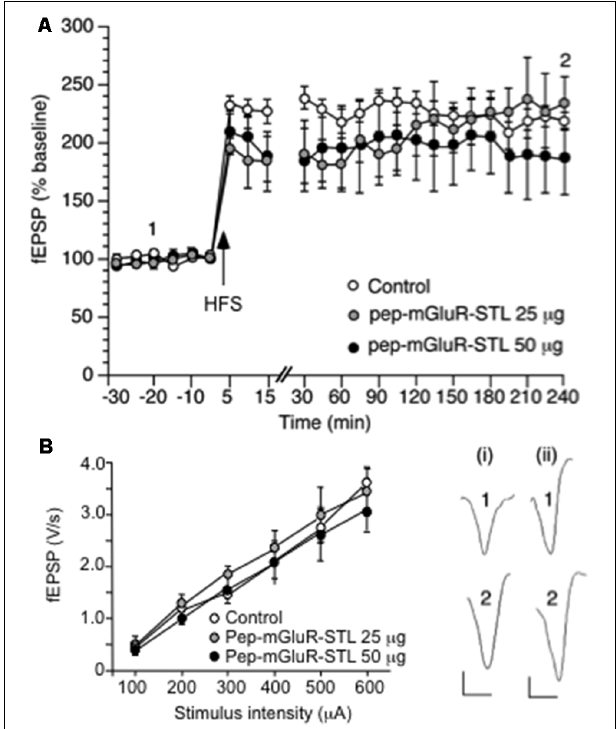
FIGURE 2 | Long-term potentiation (LTP) and the stimulus-response relationship are not altered by pep-mGluR-STL. (A) High frequency stimulation (HFS) induces robust LTP that lasts for at least 4 h in the CA1 region of hippocampal slices from animals that were treated with control peptide ( n = 8). Treatment of animals with pep-mGluR-STL (25 µ g, n = 5, or 50 µ g, n = 5), has no effect on the expression of LTP. Line-break indicates change in time-scale. Analogs represent responses elicited in the presence of: (i) control peptide; and (ii) pep-mGluR-STL (25 µ g) at the time-points noted. Vertical bar: 1 mV, Horizontal bar: 10 ms. (B) Comparison of the stimulus–response (input/output) relationship in hippocampi from animals that had been treated with control peptide, 25 µ g or 50 µ g of pep-mGluR-STL (all n = 7) revealed no differences in field excitatory postsynaptic potential (fEPSP)